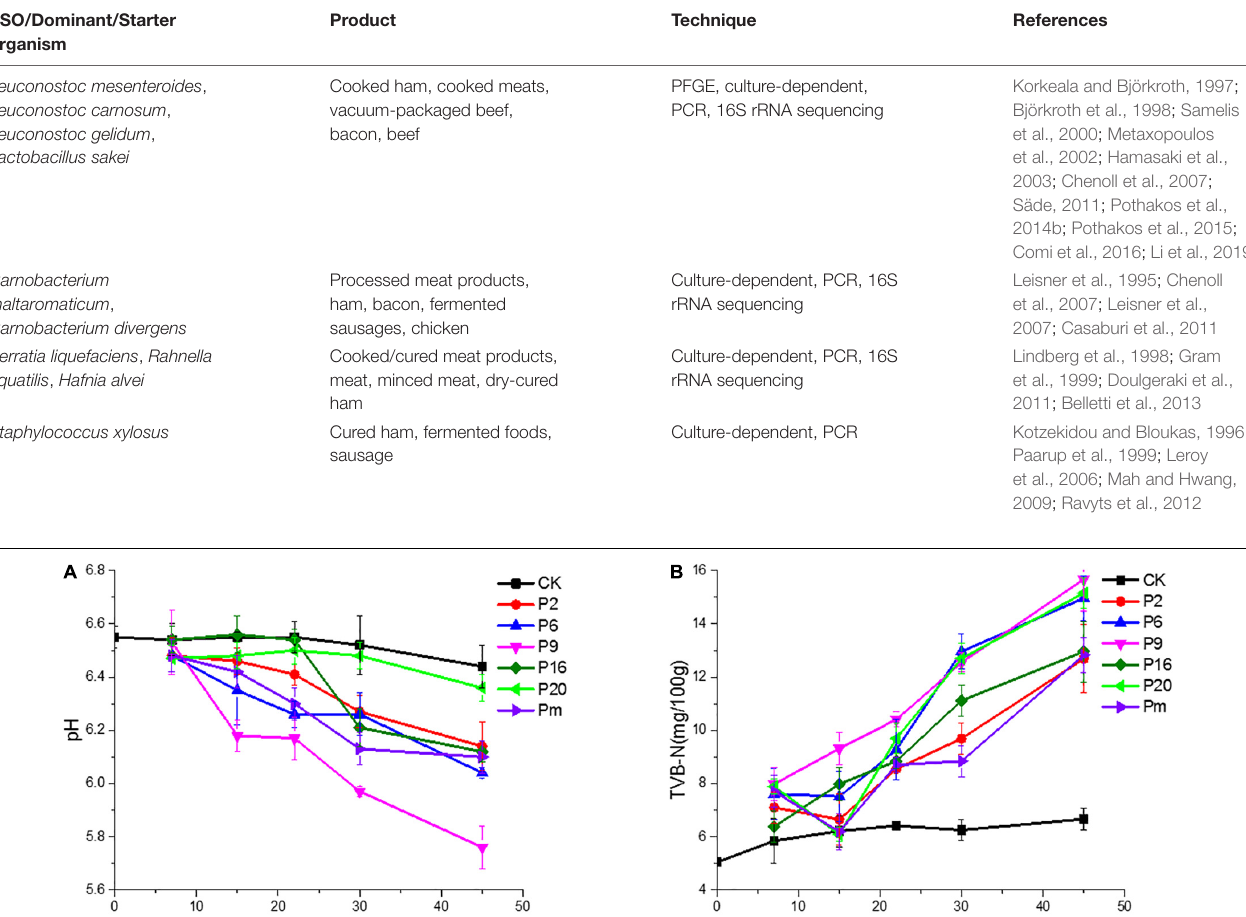
TABLE 1 | SSO/Dominant/Starter organism and the technique used in their determination in meat and meat products.